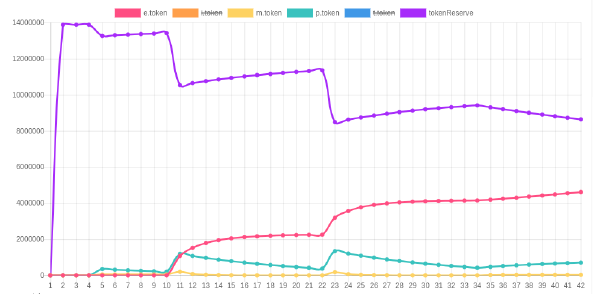
Figure 3. Token distribution between agents